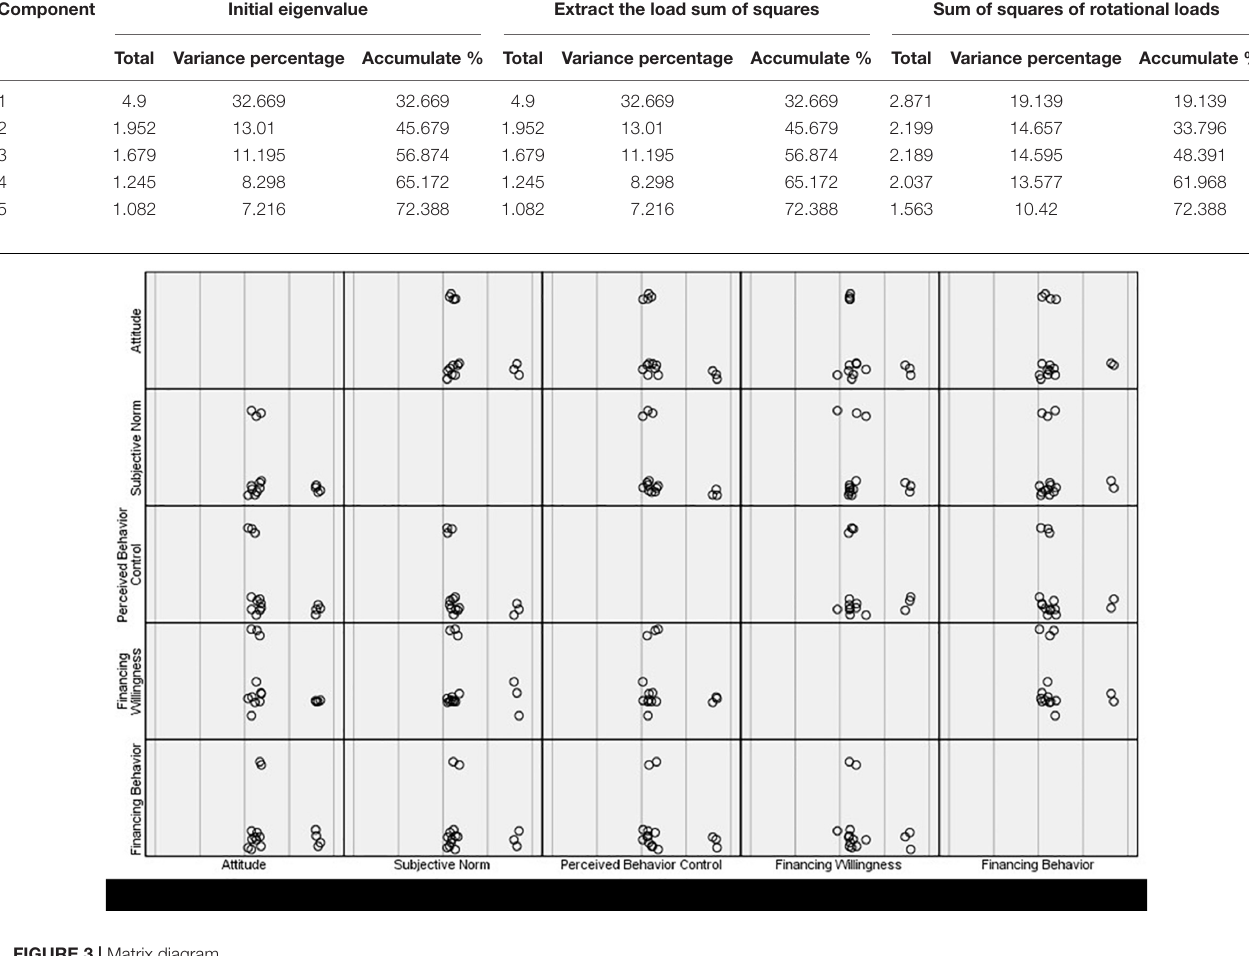
FIGURE 3 | Matrix diagram.